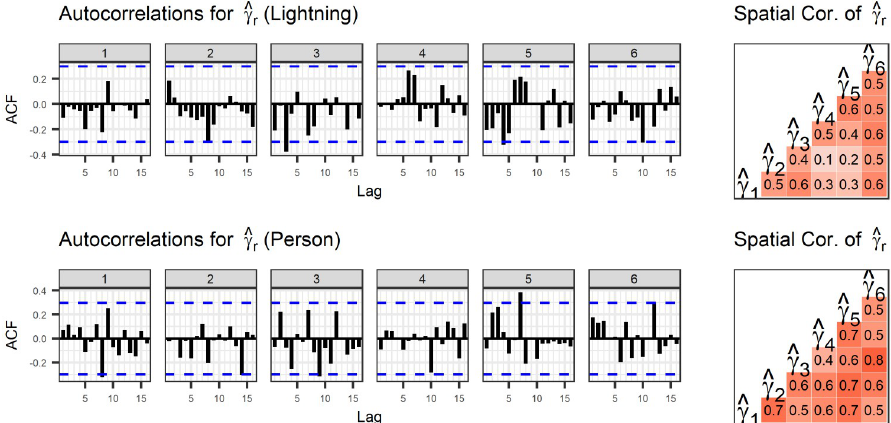
Fig 6. Correlation of the estimated linking parameter across space and time. The linking parameter in one year does not appear to predict the linking parameter in the next year. The linking parameter for lightning-caused fires is correlated for regions 1 and 2 (which are both interior from the coast and with similar forest cover) and regions 4 and 5 (which have no clear similarities). There is province-wide correlation among the linking parameters for person- caused